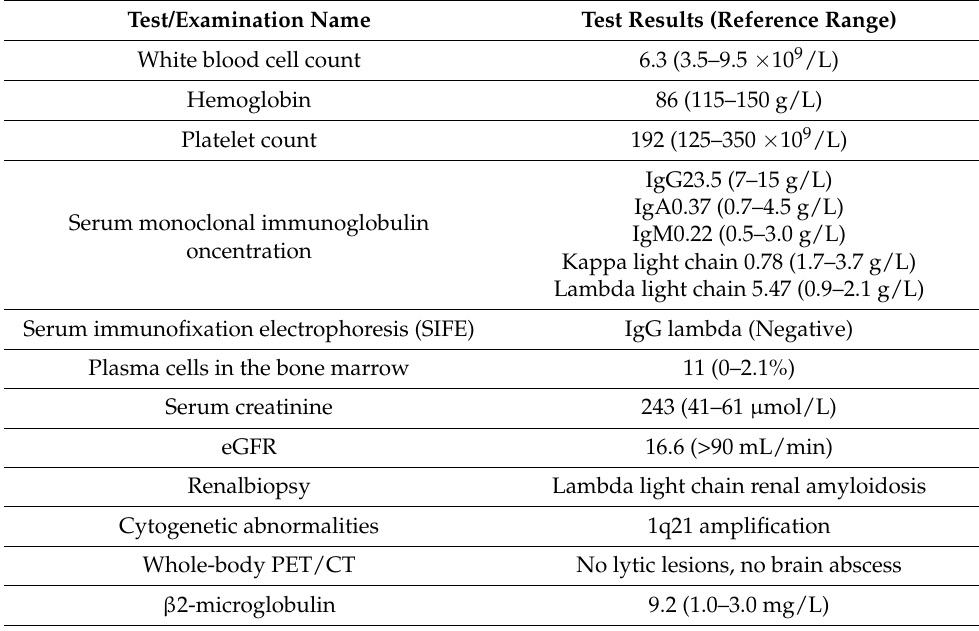
Table 1. Initial laboratory workup, including reference